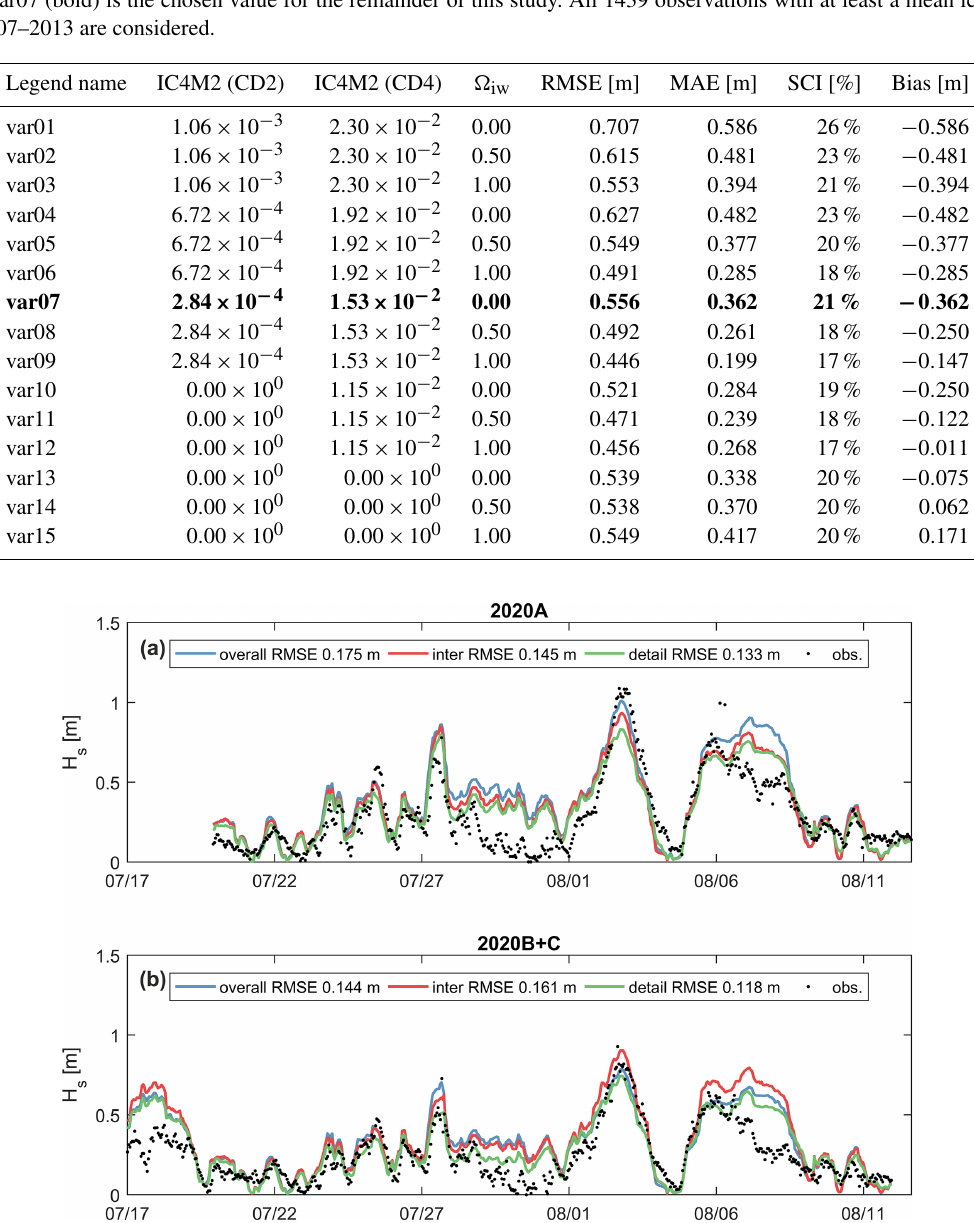
Figure 7. Significant wave height as observed (black dots) and modeled (colored lines). Three model domains are presented: overall (red), intermediate (blue), and detailed (green) domain. Upper panel (a) is 2020A (Spotter no. 0518), and bottom panel (b) is 2020B and 2020C (Spotter nos. 0519-1 and 0519-2). See Fig. 1 for the extent and locations of these